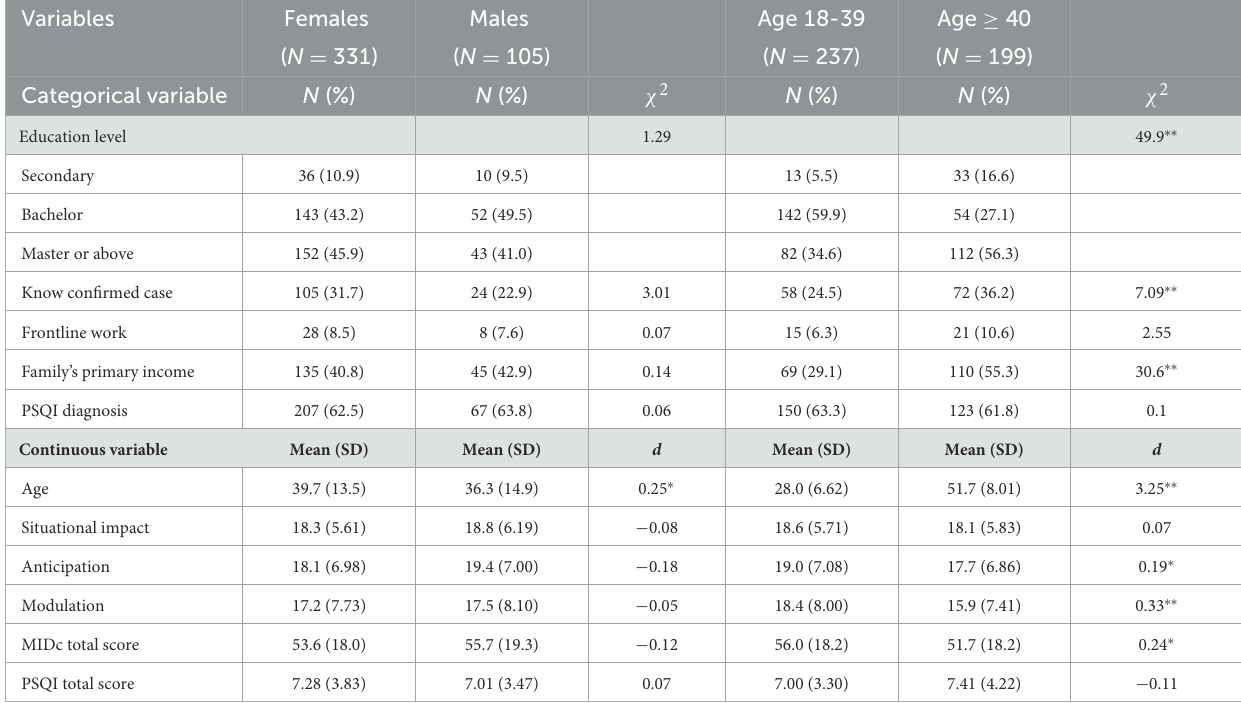
TABLE 1 Demographics and psychological profiles of the sample across gender and age subgroups. Variables